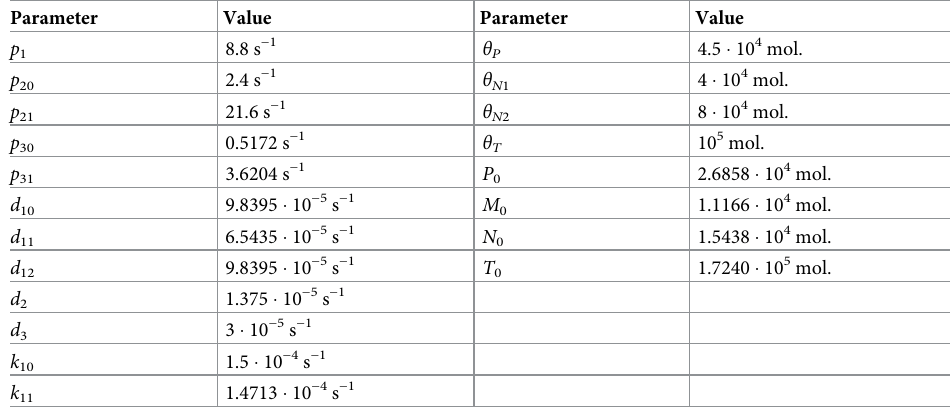
Table 2. Parameters, thresholds and initial values for the model with